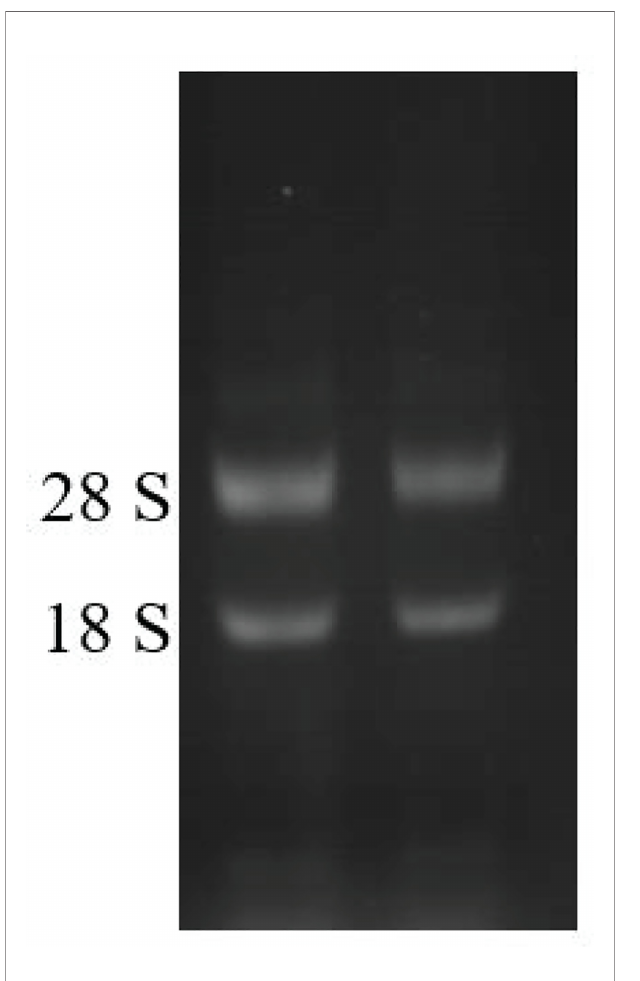
FIGURE 6 | Total RNA from D. parva cells. Lanes 1 and 2 represented the total RNA of D. parva cells. The integrity of RNA was detected by 1% agarose gel electrophoresis.